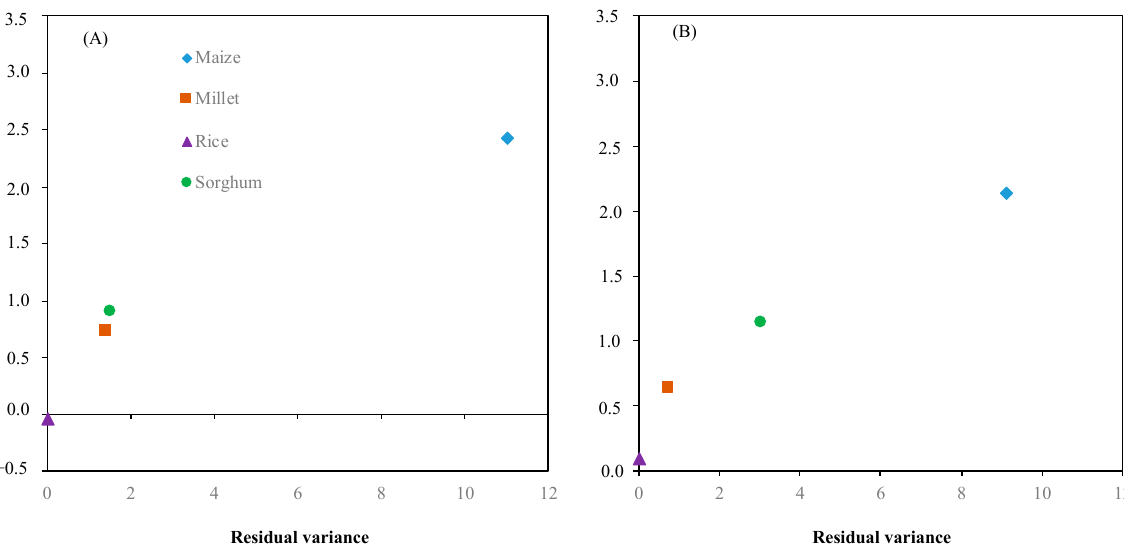
Figure 7. Interaction between the residual variance and regression coefficient of shoot dry weight ( A ) and root dry weight ( B ) for evaluating crops: maize ( ◆ ), millet ( ■) , rice ( ▲ ), and sorghum ( ● ) adapted to environment (soil moisture).